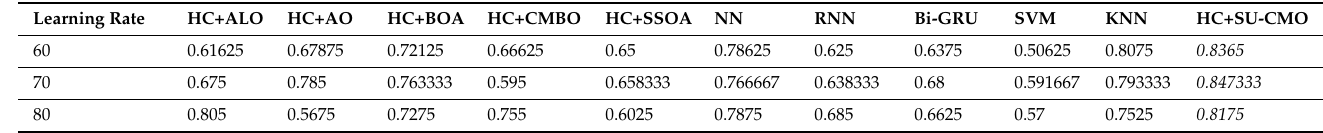
Table 3. Accuracy Analysis of the proposed model over other methods for dataset